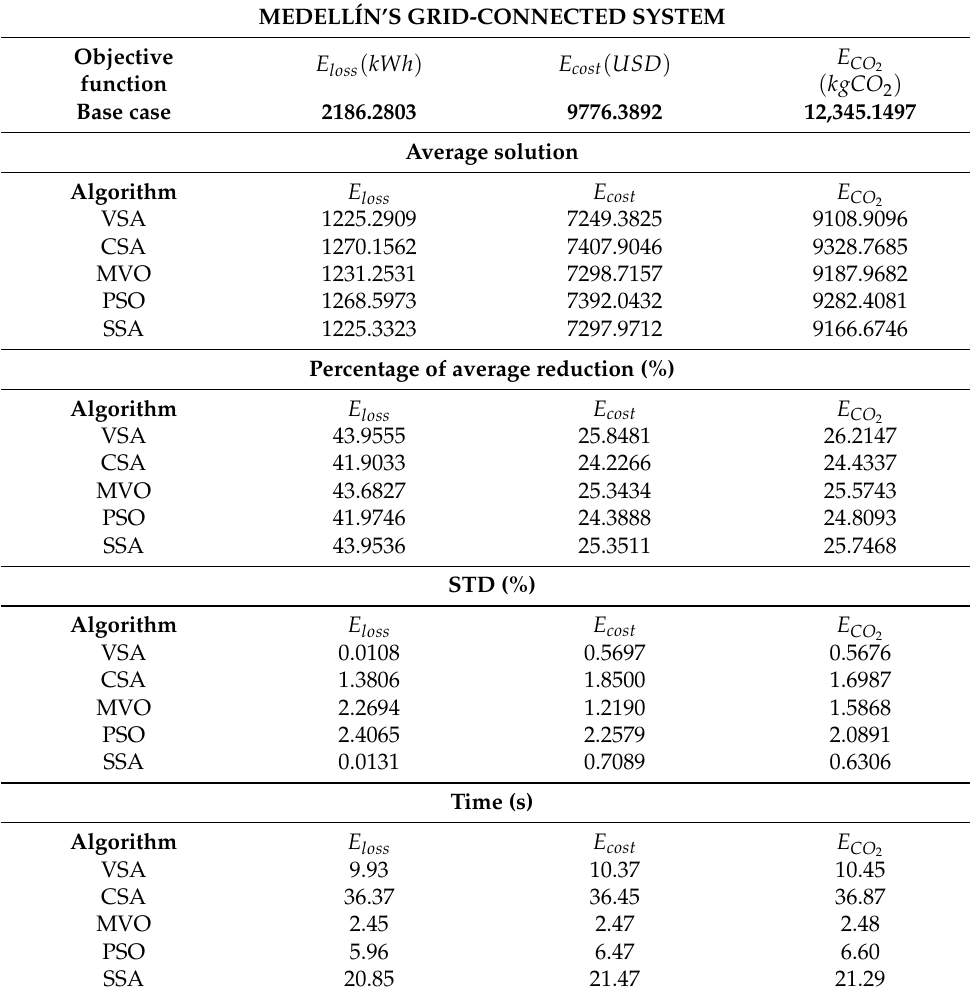
Table 11. Simulation results obtained by the optimization algorithms in grid-connected